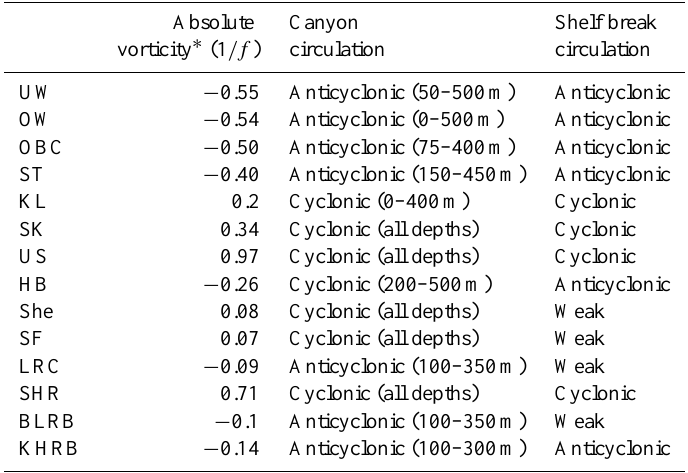
Table 6. Absolute vorticity and canyon circulation for all model simulations. Values are averaged during the advection-dominated phase (model days 4–10).